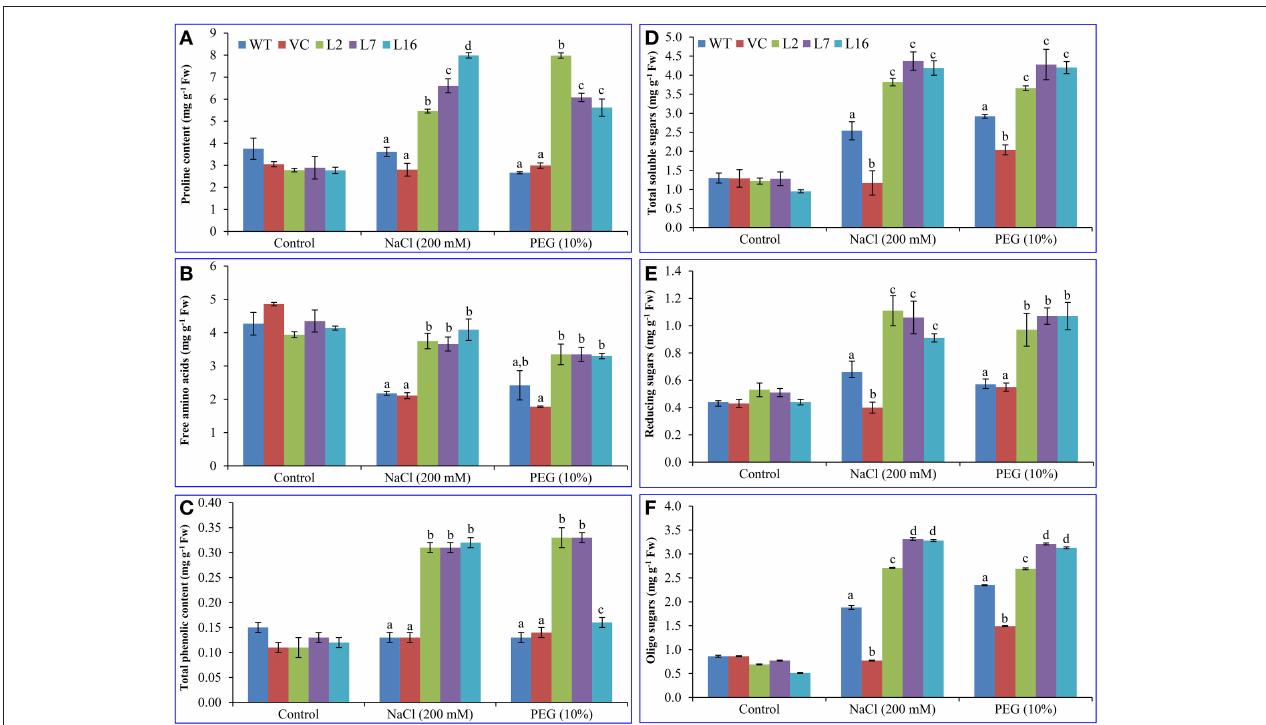
FIGURE 5 | Biochemical analyses of transgenic tobacco plants under abiotic stress. Estimation of (A) proline, (B) free amino acids (FAA), (C) total phenolic content (polyphenol; TPC), (D) total soluble sugars (TSS), (E) reducing sugars (RS), and (F) oligo sugars (OS) in control (WT and VC) and transgenic plants (L2, L7, and L16) under salinity and osmotic stress condition. Bars represent means ± SE and values with different letters are significant at P <